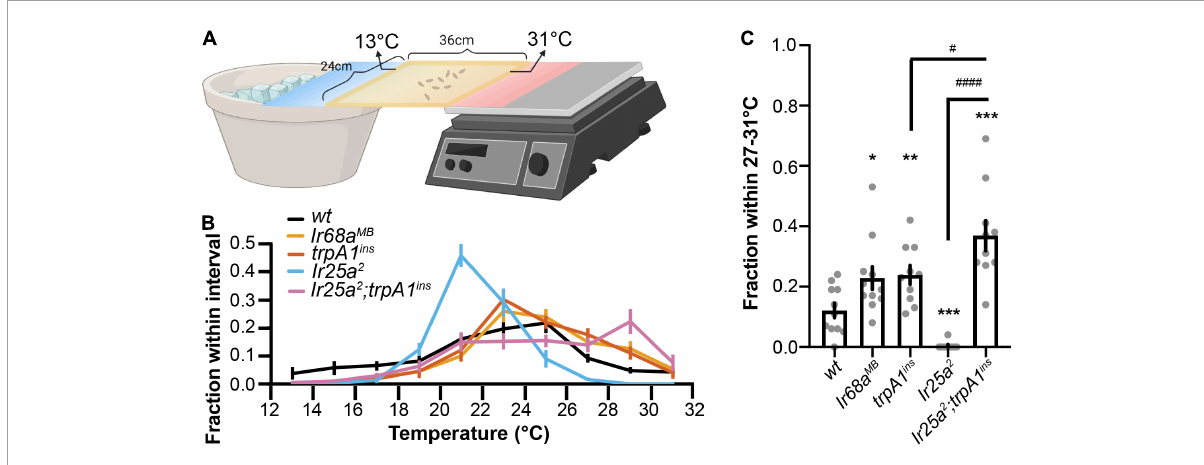
FIGURE4 Cool and warm receptors exert opposite effects in a gradient thermotaxis. (A) The schematic of larval gradient thermotactic assay (created with BioRender). Early third-instar larvae were released in the middle of a testing gel at ∼ 22 ◦ C and were given between 10 and 15 min to make temperature selections. The number of larvae in each temperature zone was counted and the distribution was calculated as follows: (number of larvae in each temperature zone)/(total number of larvae). (B) Larvae distribution along a thermal gradient of indicated genotypes. (C) Fraction of larvae of indicated genotypes in the 27 ◦ C–31 ◦ C region. n = 9–11; data represent means ± s.e.m; * P < 0.05, ** P < 0.01, and *** P < 0.001, comparing to wt ( CS ); # P < 0.05 and #### P < 0.0001, comparing to Ir25a 2 ; trpA1 ins . The Welch’s test was applied to the comparison of wt and trpA1 ins , wt and Ir25a 2 ; trpA1 ins , and trpA1 ins and Ir25a 2 ; trpA1 ins . The Mann–Whitney test was applied to the comparison of wt and Ir68a MB , wt and Ir25a 2 , and Ir25a 2 and Ir25a 2 ; trpA1 ins